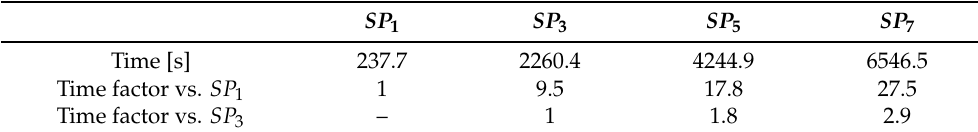
Table 6. Comparison of computational times for different SP L approximations.